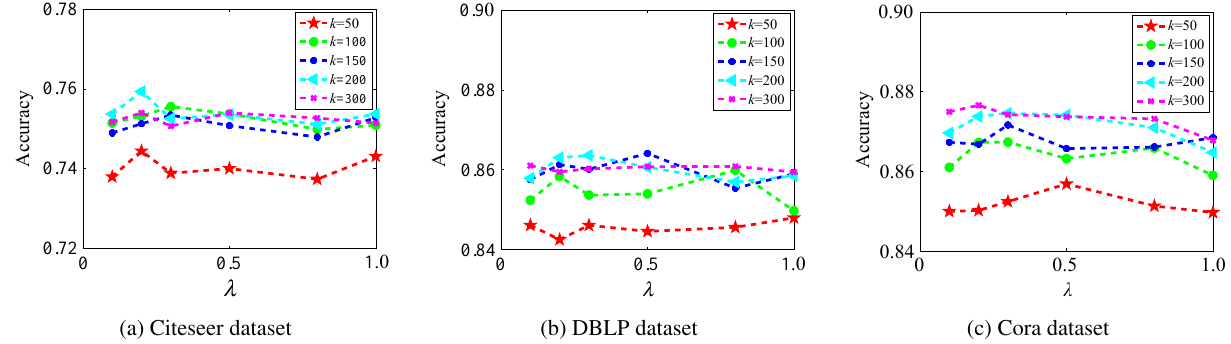
Fig. 4 (cid:21)(cid:21)(cid:21) and k sensitivity analysis on Citeseer, DBLP, and Cora